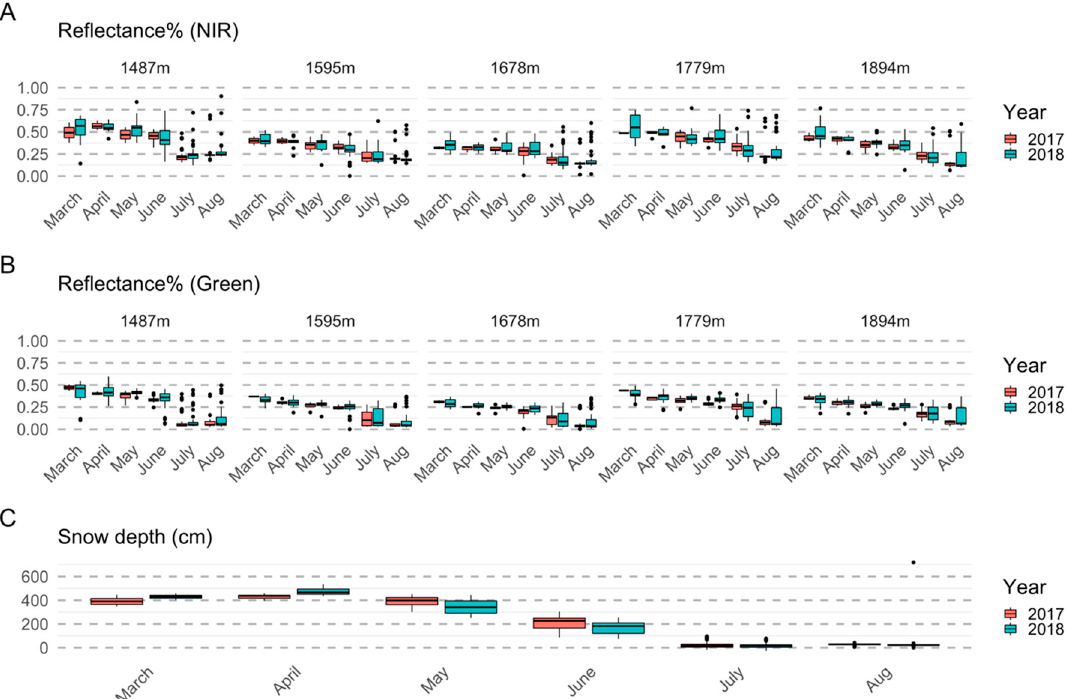
Figure A2. Planet reflectance comparison of NIR and green band showing snowmelt followed by green-up and flowering. ( A ) NIR reflectance is higher in snow months than in vegetative and flowering months, signified by positive correlation of reflectance’s with snow-depth. ( B ) Green reflectance shows lower reflectance (i.e., higher absorption) after the snow-melt, signifying green-up. ( C ) Snow-depth plot from the metrological records highlighting snow-free months after June.